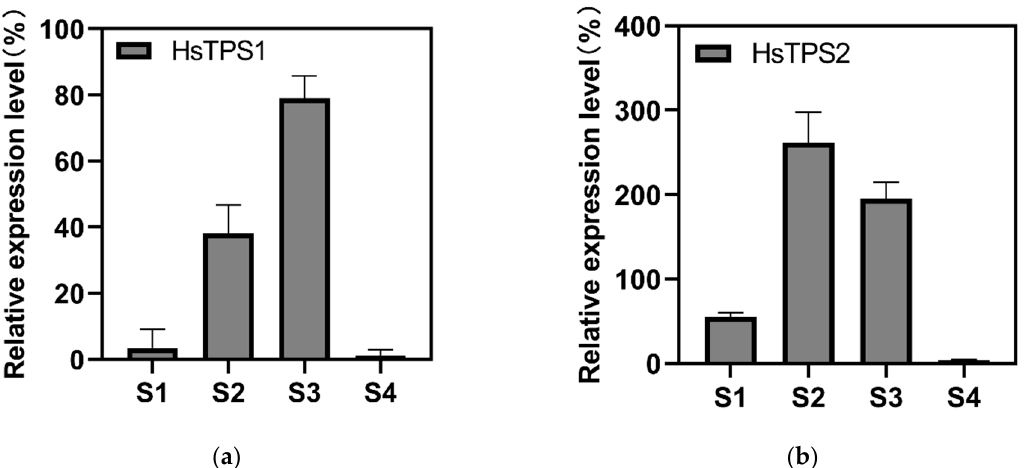
Figure 5. Relative expression analysis was performed by qRT-PCR using Actin as reference genes. ( a ) Relative expression levels of Hs TPS1 ; ( b ) Relative expression levels of Hs TPS2 . The relative transcription level in tissue with the highest expression quantity was set to 1 (100%). Each bar represents the mean value ± SE of three biological and three technical replicates ( p -value < 0.05). The stage of flower buds two or three days before full bloom (S1); flower buds one day before full bloom (S2); full-bloom flowers for one day (S3); and flowers one day after full bloom (S4). Table 1. Terpenoids identified from Hosta flower volatiles of two different developmental floral stages using GC–MS analysis. All compounds were identified using the NIST database and quanti- fied by comparing the peak area with the internal standard ethyl decylate. Data are presented as means (±SE, n = 3).